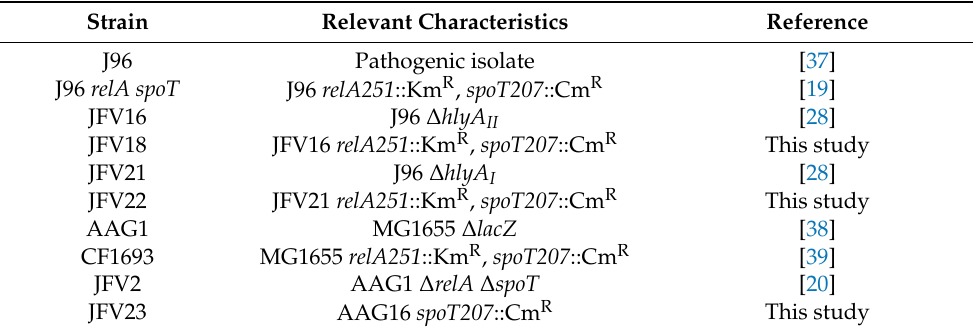
Table 1. Strains and plasmids used in this